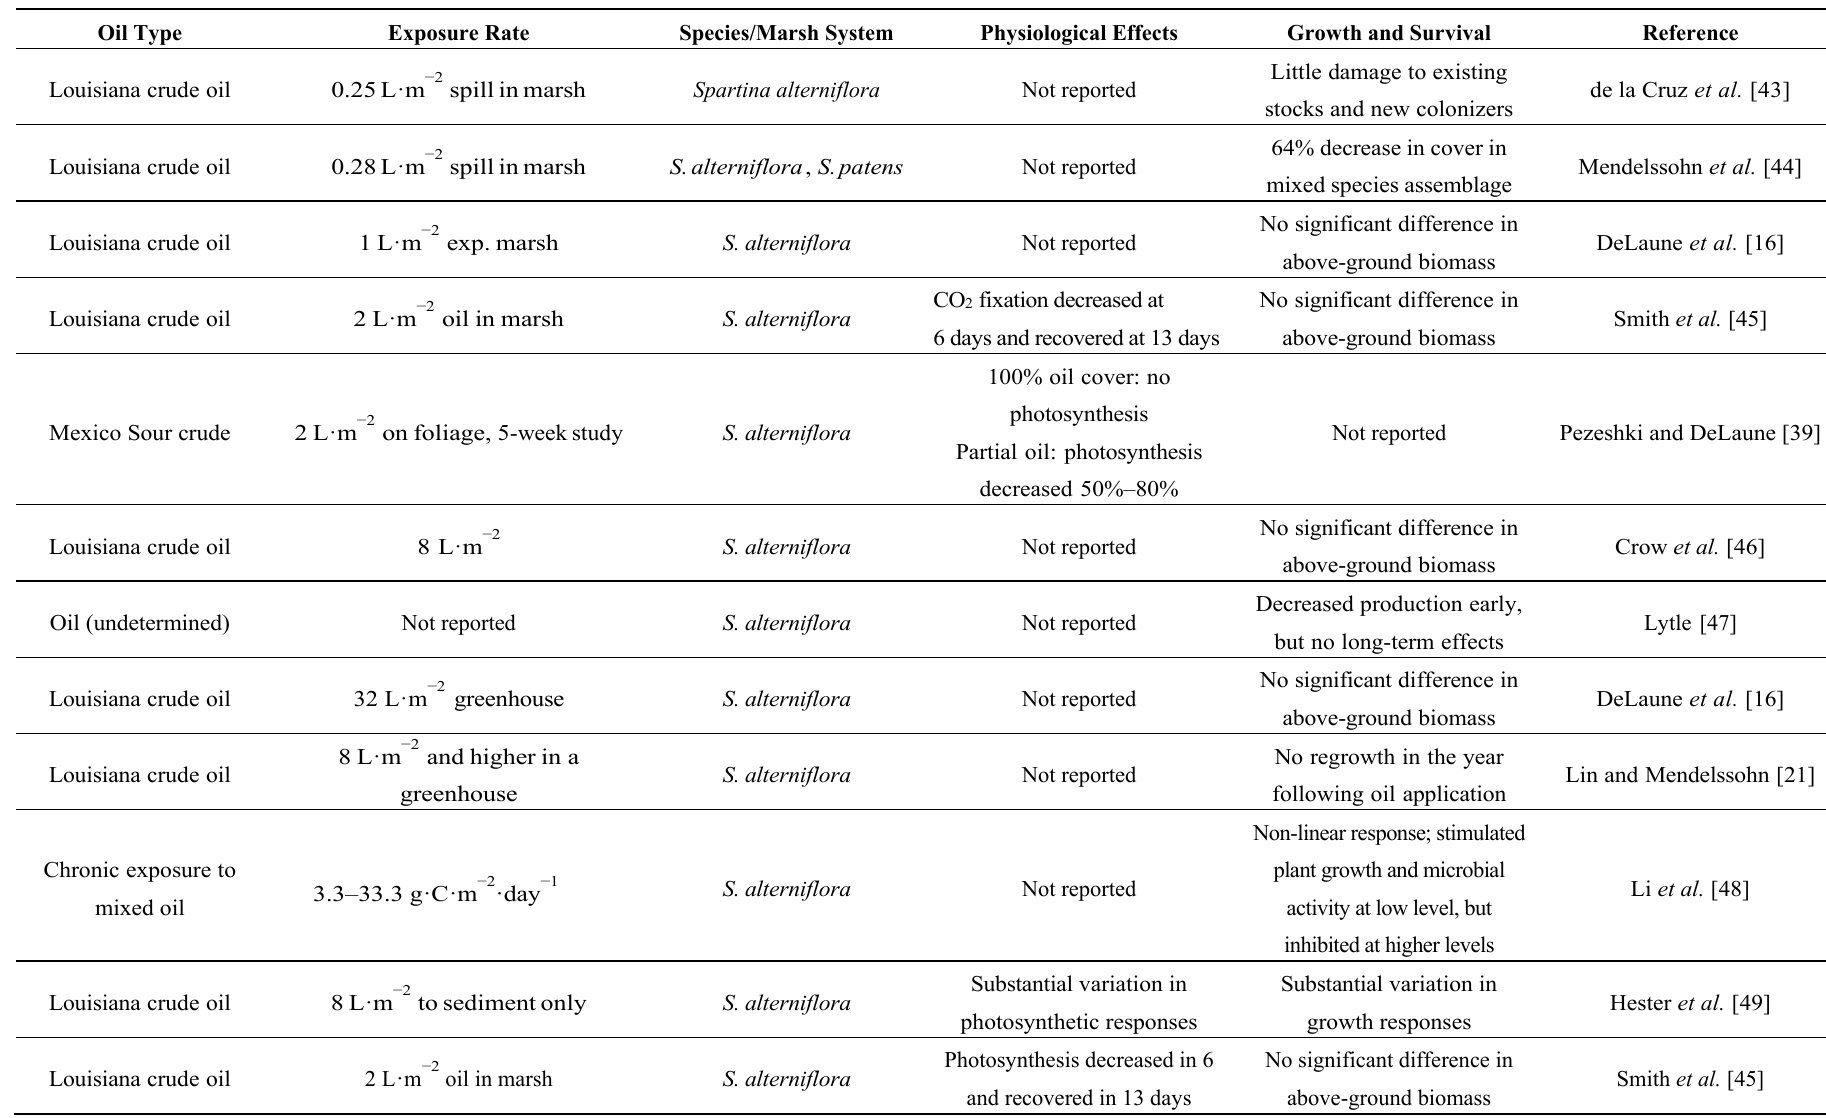
Table 1. Effects of oil on US Gulf coastal brackish and saltmarsh